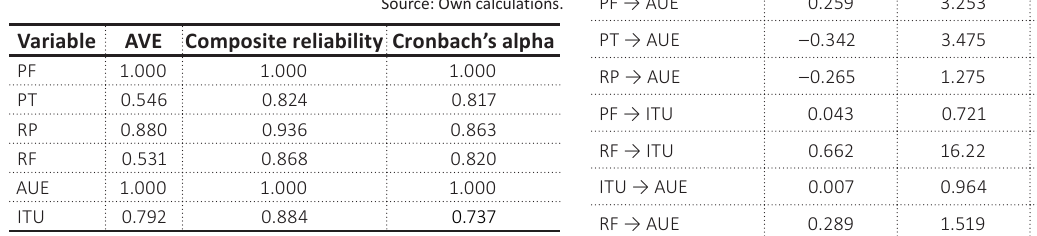
Table 3. Result of validity and reliability